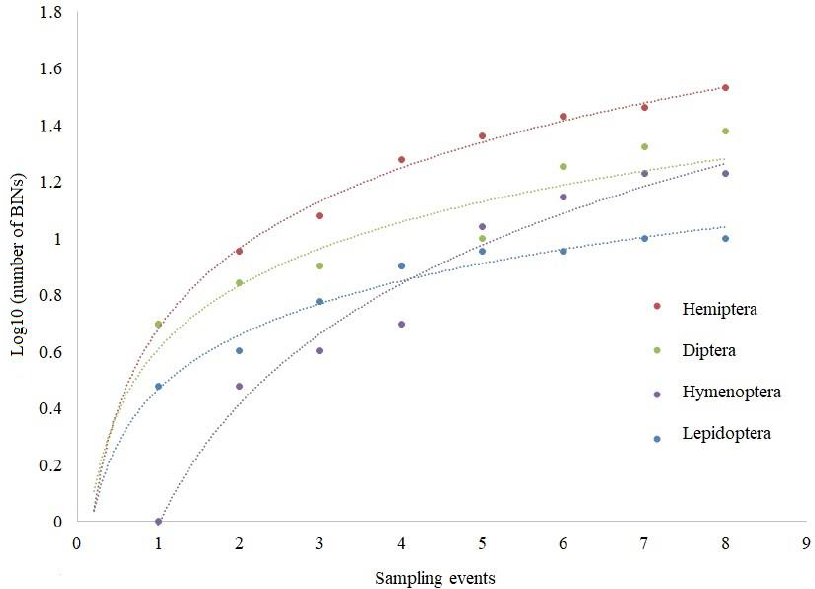
Figure 3. Rarefaction curves of the number of different BINs for selected groups shown as a function of the number of sampling events.